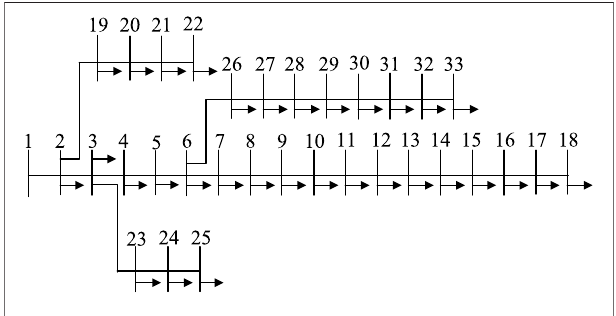
FIGURE 4 | IEEE 33-bus distribution network.